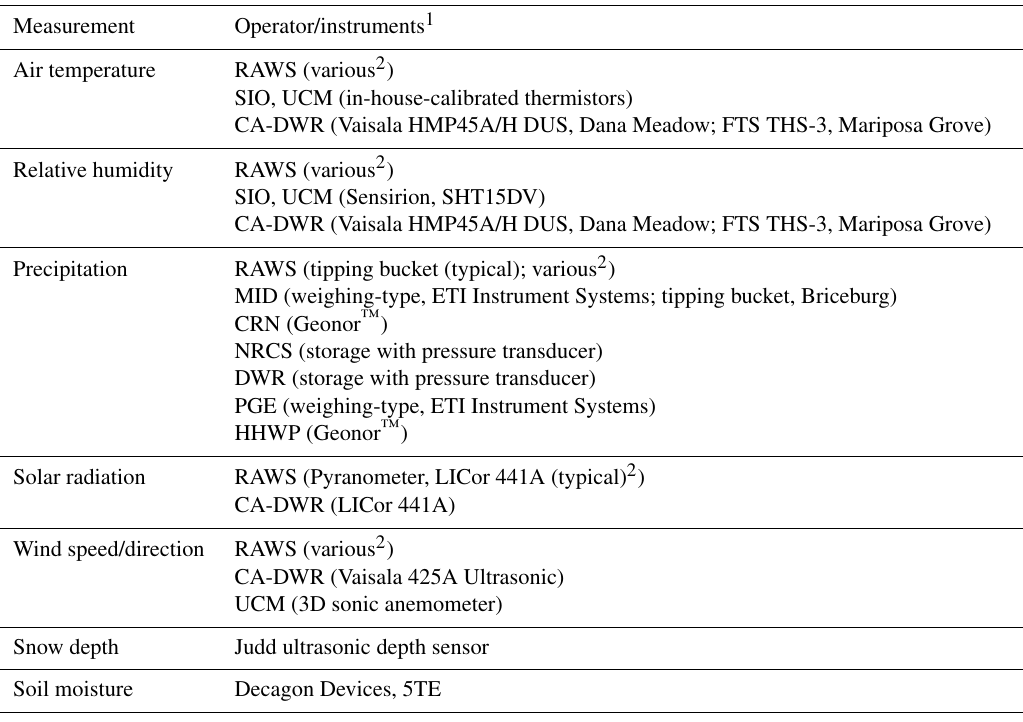
Table 1. Measurements, operator, and instrumentation at each